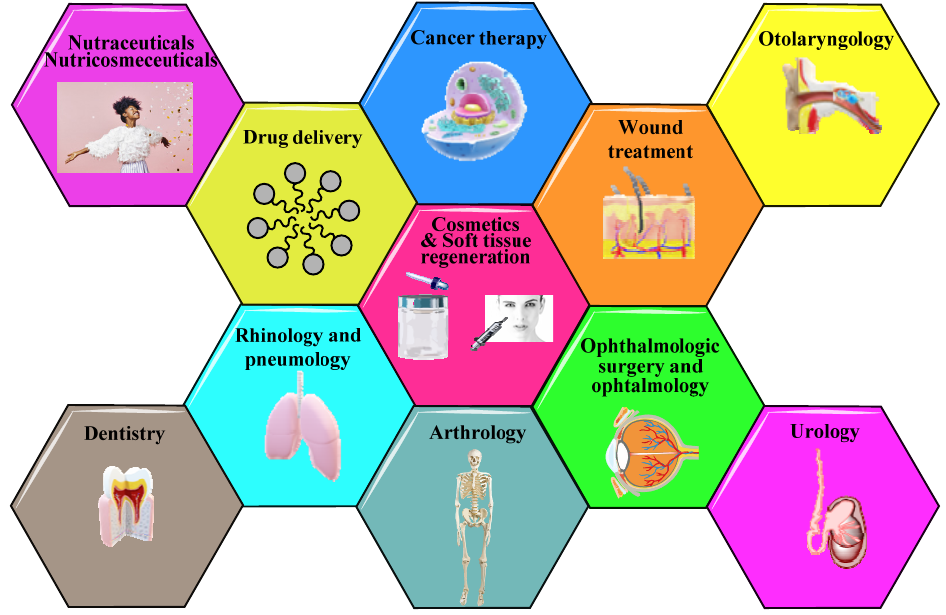
Figure 3. Cosmetic, pharmaceutical, and medical applications of HA and its